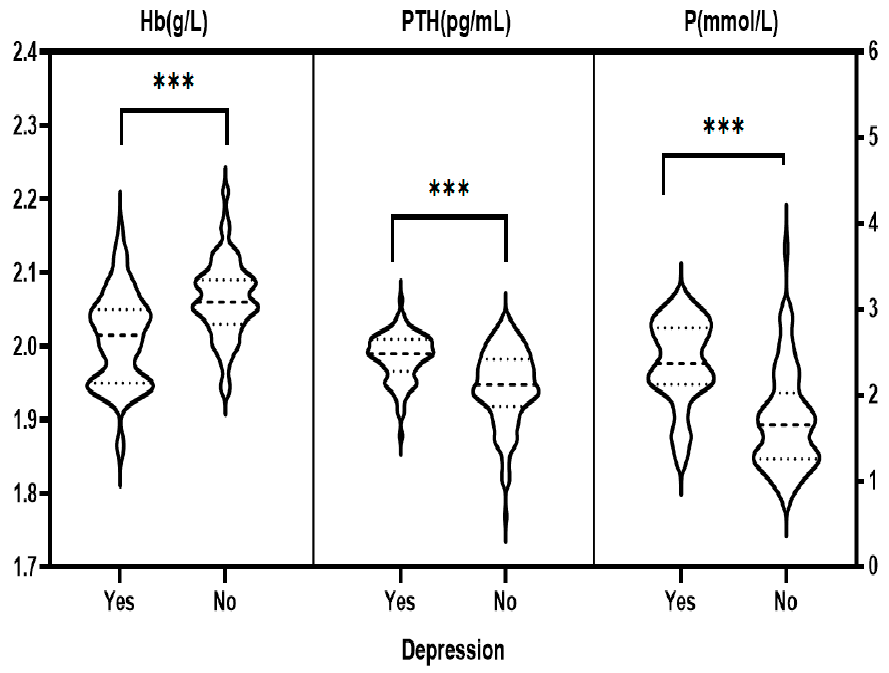
Figure 4. Single-factor analysis of depression in the MHD patients with laboratory tests. Note: PTH, Hb values were log-converted. *** p <